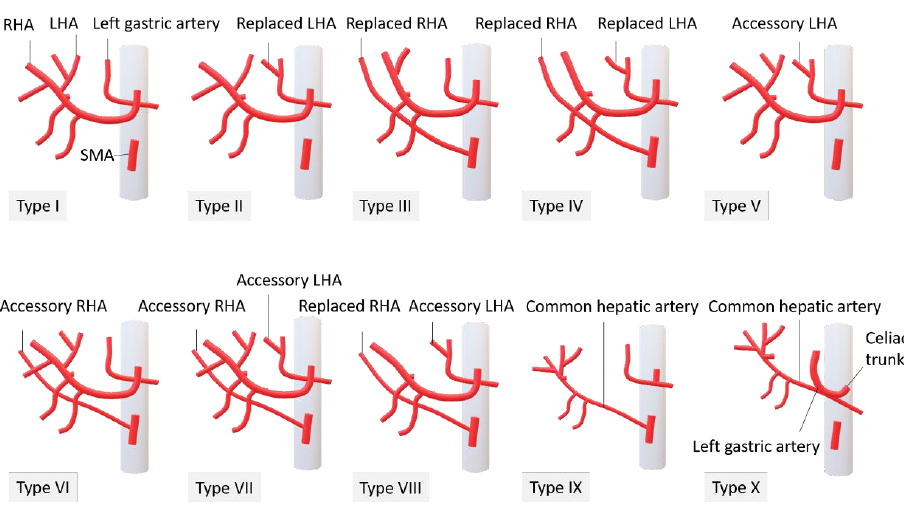
Figure 1. Michel’s classification of hepatic arteries, manually drawing courtesy of Miss Wan